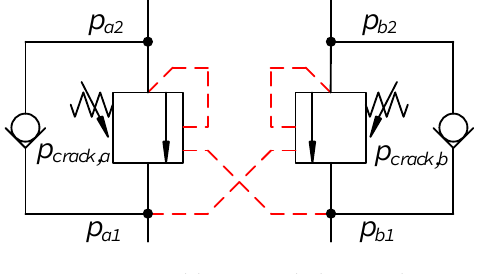
Figure 7. Double counterbalance